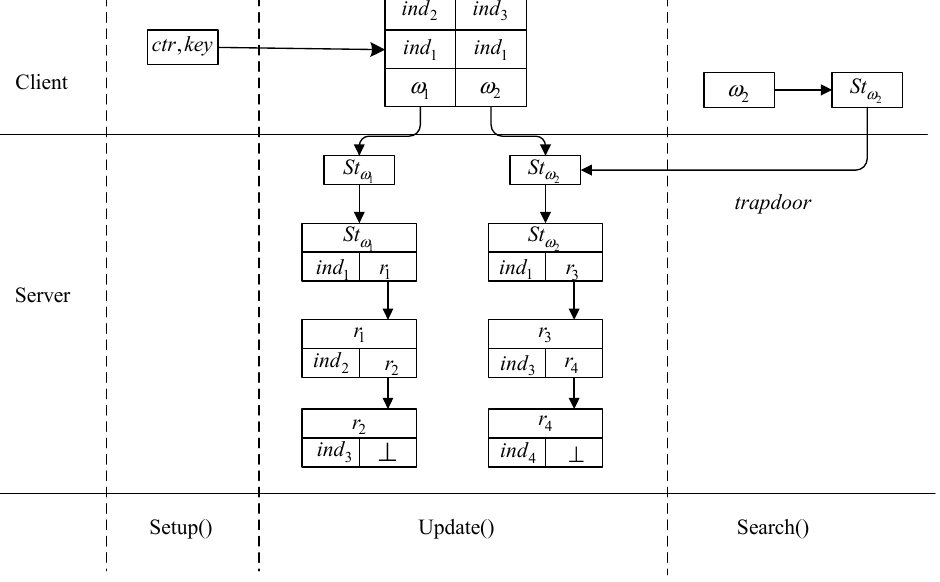
− 3. System Model The system model adopted by our proposed scheme is shown in Figure 3 and has three entities: the client, the PKG, and the server.